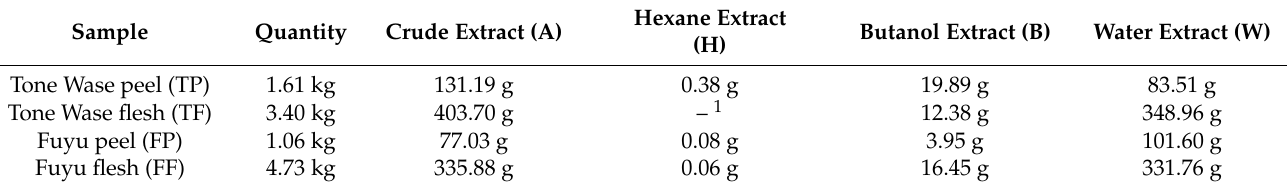
Table 1. Amounts of immature persimmon samples and